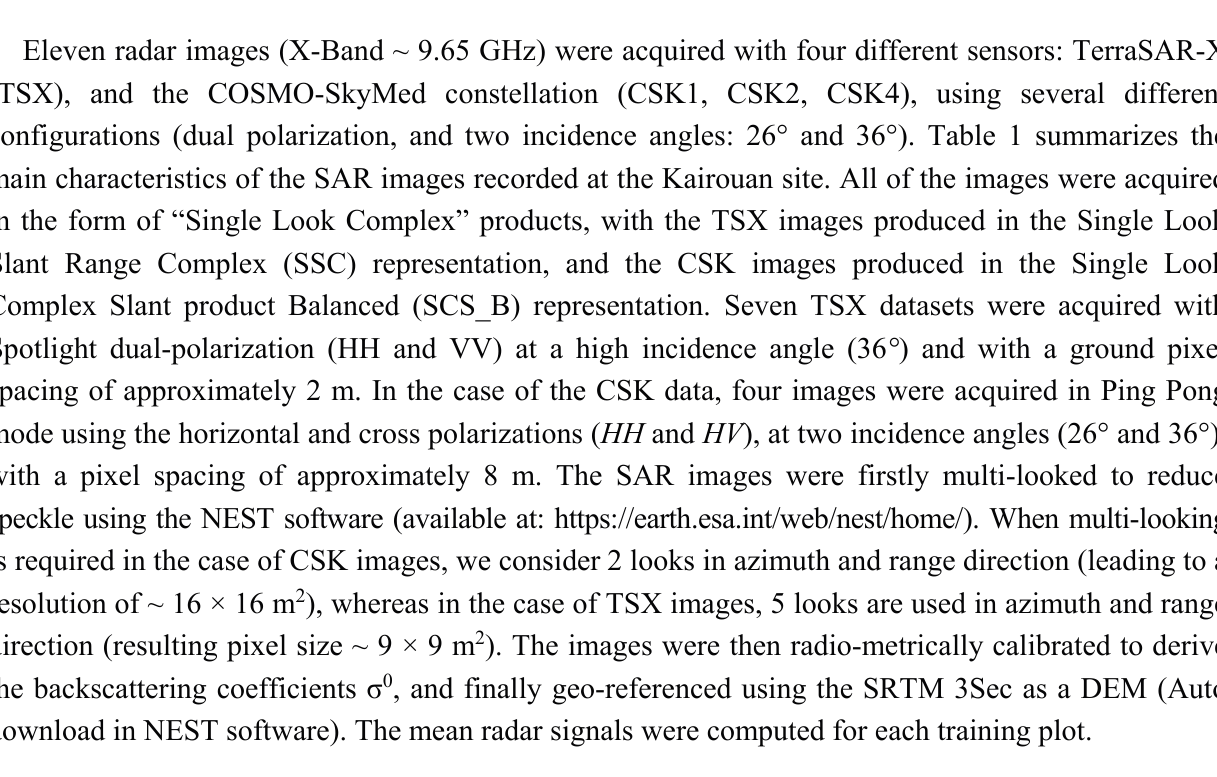
Table 1. Main characteristics of the X-band SAR images: Pol: Polarization, Inc: Incidence Angle, Desc: Descendant and Asc: